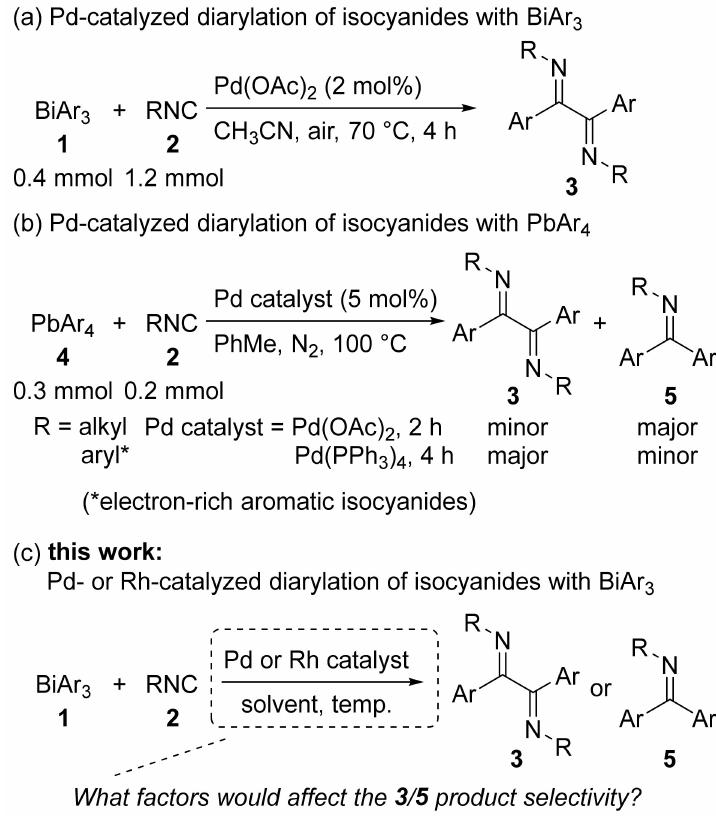
Scheme 1. Transition-metal-catalyzed diarylation of